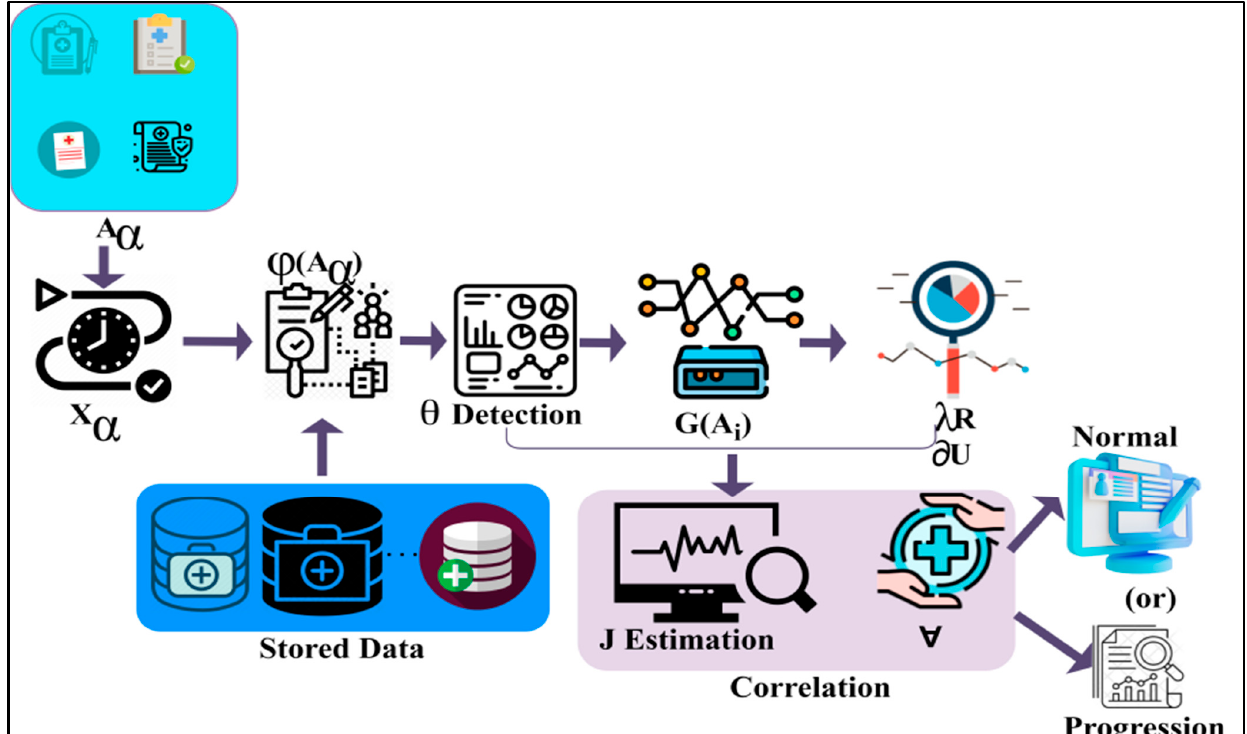
Figure 5. The variance-based progression detection